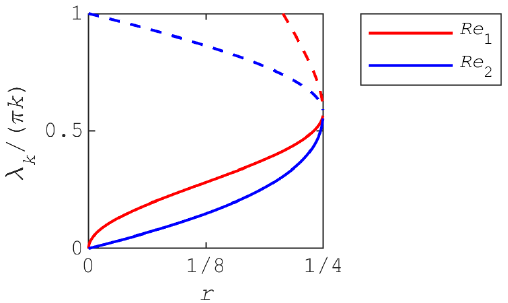
Figure A1. Roots of the dispersion relation λ k for two branches of the numerical parameter Re . Solid and dashed lines show maximal and minimal roots,